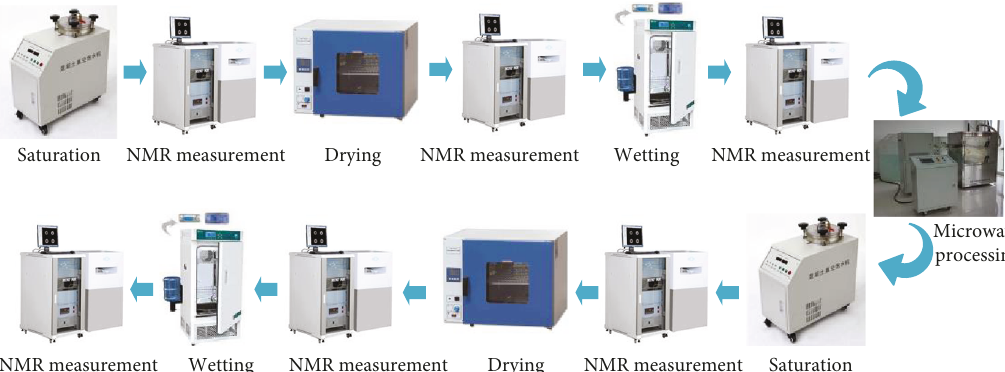
Figure 3: Experimental procedure for NMR